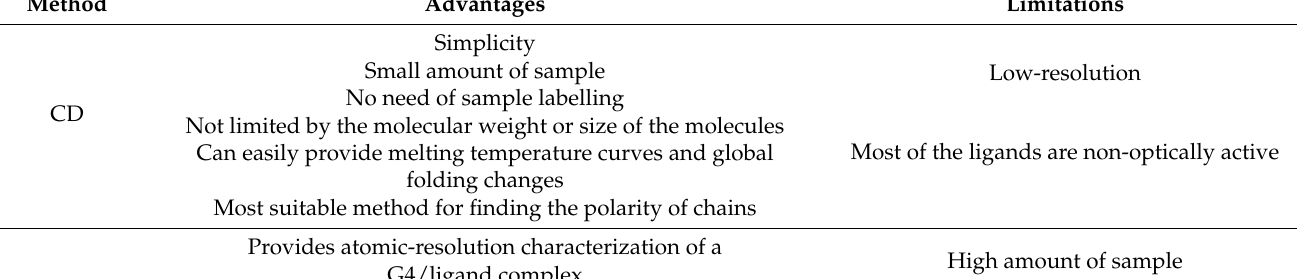
Table 1. Advantages and limitations of structural-based methods for investigating G4/ligand interactions.